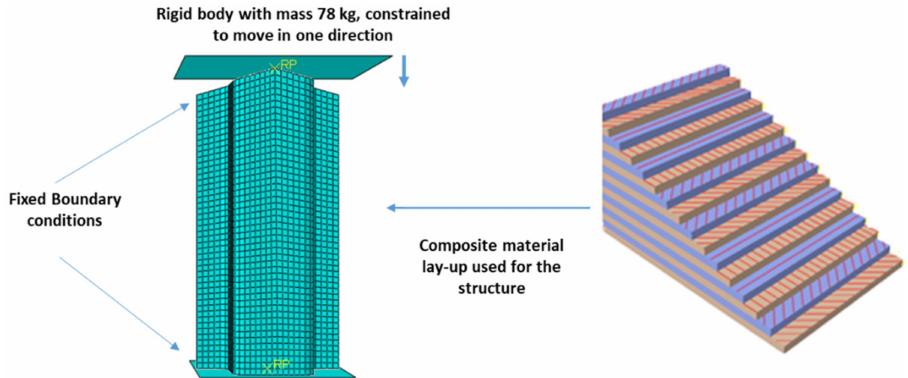
Figure 6. Top-hat geometry, boundary conditions and